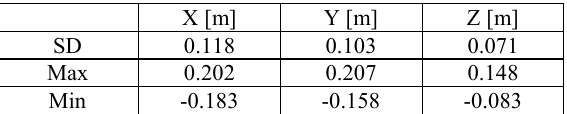
Table 4. Achieved accuracy of UTM transformation of projection centres of